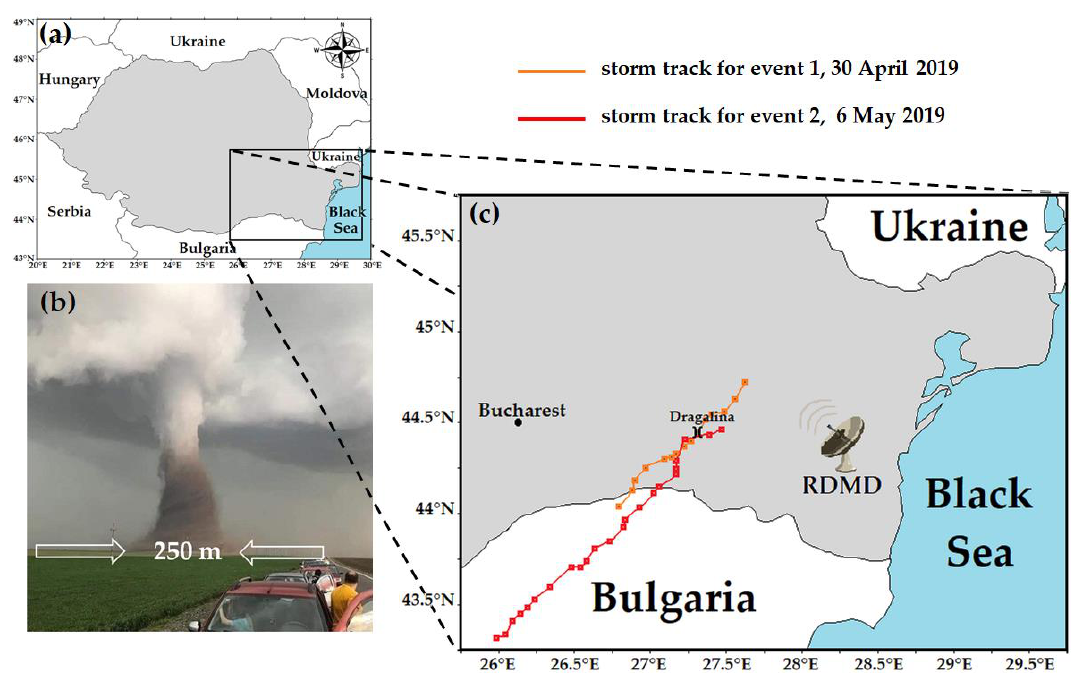
Figure 1. ( a ) Romanian territory (grey) with the watch area marked in black rectangle; ( b ) the tornado evidence for 30 April 2019, image posted on Facebook by Oscar Stanciu [48] ( c ) details of the watch area where the convective events occurred on 30 April 2019, 14:00–15:00 UTC (event 1 storm track, orange line ) and on 6 May 2019, 14:45–16:30 UTC (event 2 storm track, red line ); the radar icon marks the location of the Medgidia radar (RDMD) surveying South-Eastern Romania.